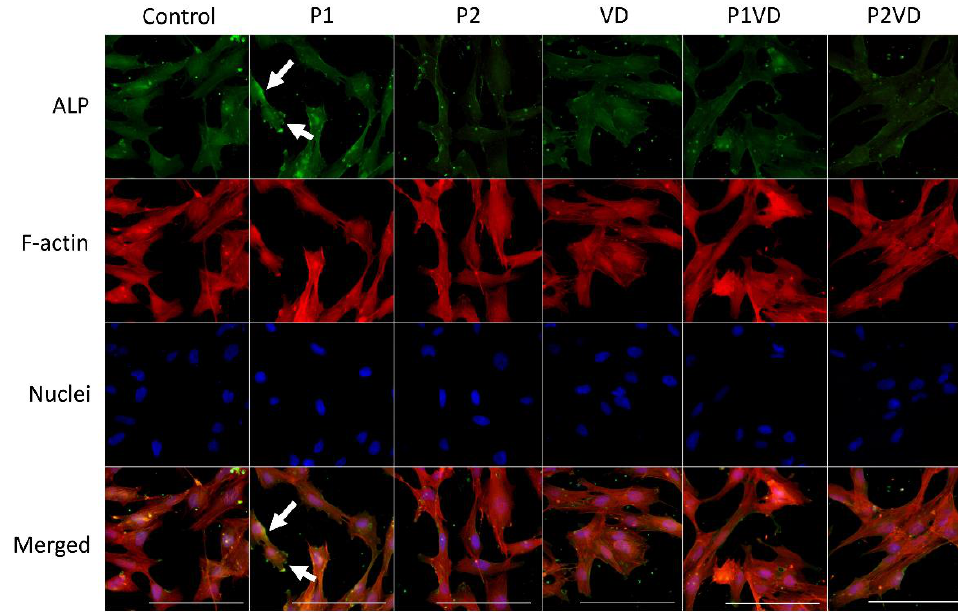
Figure 4. Representative immunofluorescence detection images of ALP, F-actin cytoskeleton (Phal- loidin), and nuclei (DAPI) in hFOB1.19 cells cultured without any treatment (Control), with VD (VD), two probiotics (P1 and P2) and their respective combinations with VD (P1VD and P2VD). White arrows indicate the highest immunofluorescence of ALP detected in P1 cells; Scale bar: 100 µm.